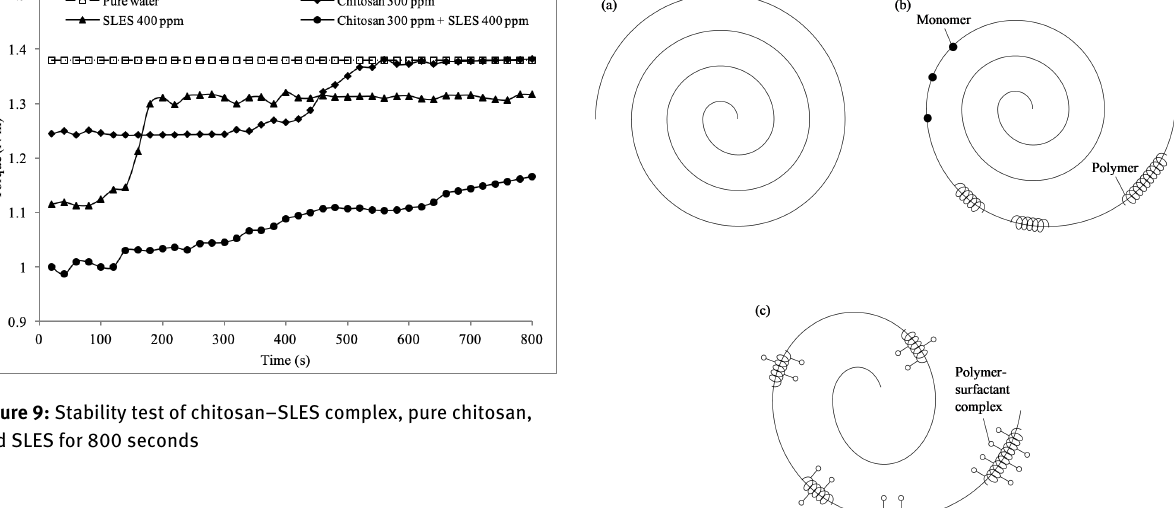
about 40% and 14.54% compared to those of pure chitosan and SLES, respectively.